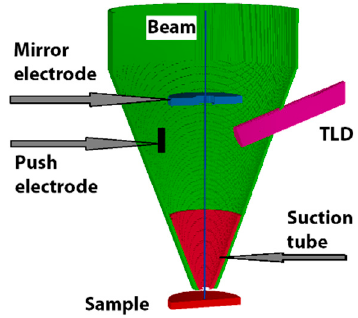
Figure 1. The arrangement used for simulation; through-the-lens detector and auxiliary electrodes inside the objective lens are shown schematically.